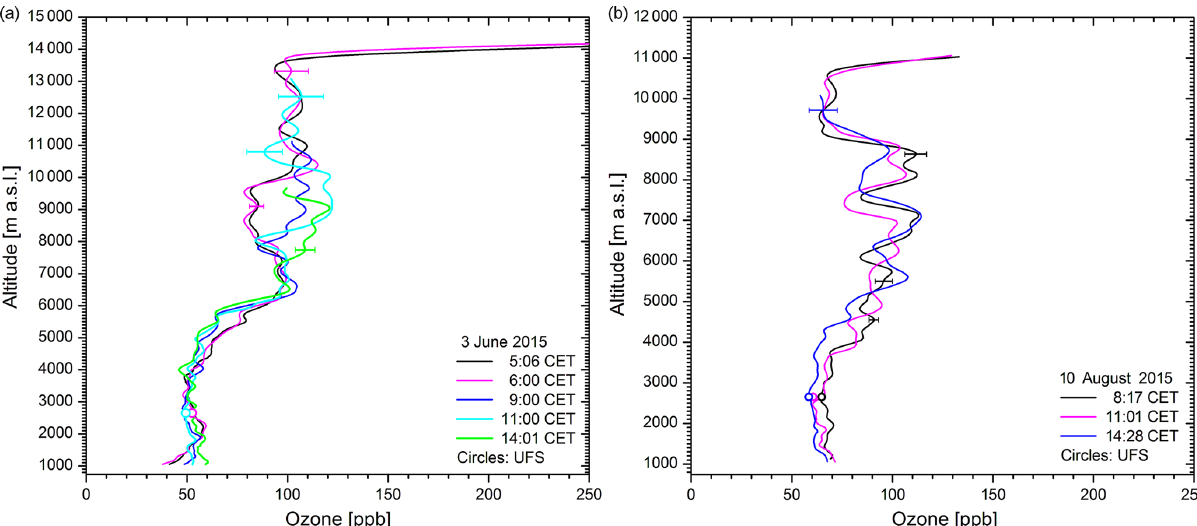
Figure 9. Ozone profiles from 3 June 2015 (a) and 10 August 2015 (b) showing very high ozone above 5 and 3.8km, respectively; the high values are mostly explained by STT. The in situ data (1h averages) of UFS (2670m) are marked with circles coded in the same colours as the lidar measurements next to the same time and confirm the values from the lidar measurements within 1 to 2ppb. Munich tropopause: